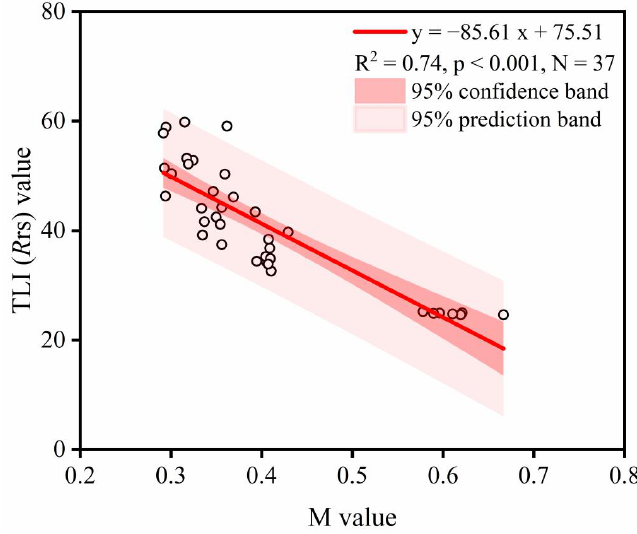
Figure 3. Scatterplots of TLI ( R rs) calibration between M value and in situ measurement TLI ( R rs) data.